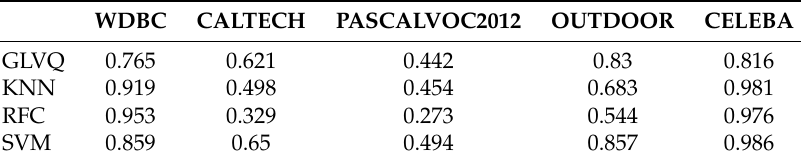
Table 5. Final classifier accuracies of real-world random sampling